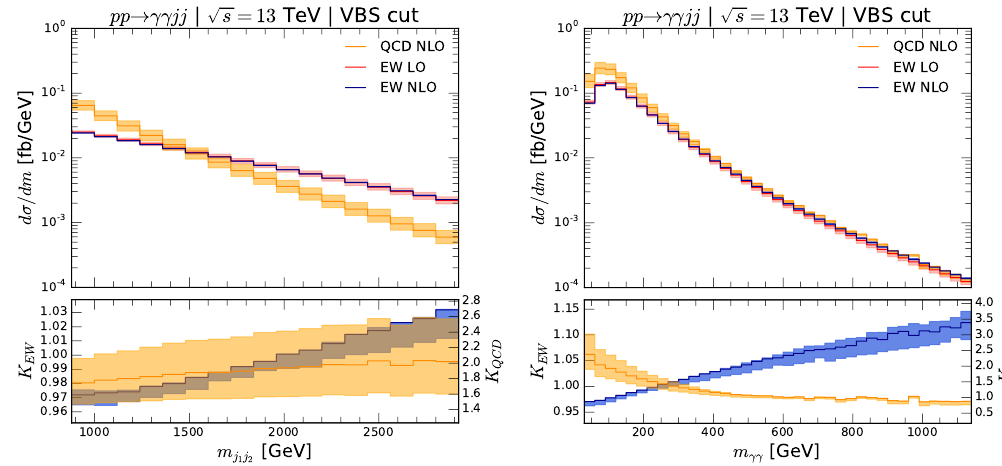
Figure 7 . Distributions of the invariant mass of the two tagging jets (left) and of the two photons (right). The scale-uncertainty bands and K -factors are calculated as in (cid:12)gure 5. q where E T;V = m 2 + p 2 with m V being the reconstructed mass. With this setup, V T;V